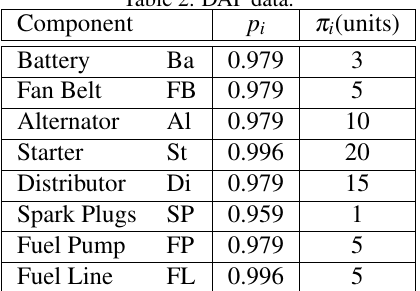
Table 2. DAP data.